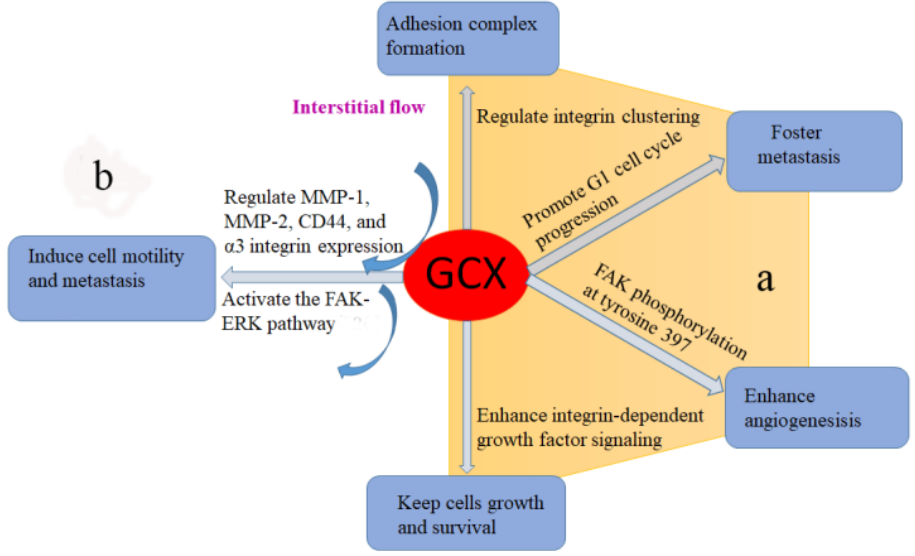
Figure 2. The involvement of cancer cell glycocalyx in tumor progression. ( a ) Glycocalyx enhances growth factor storage and signaling to regulate cancer cell adhesion, angiogenesis, metastasis, growth and survival. ( b ) Glycocalyx acts as a mechanotransducer of interstitial flow-induced shear stress to regulate cancer cell motility and metastasis.